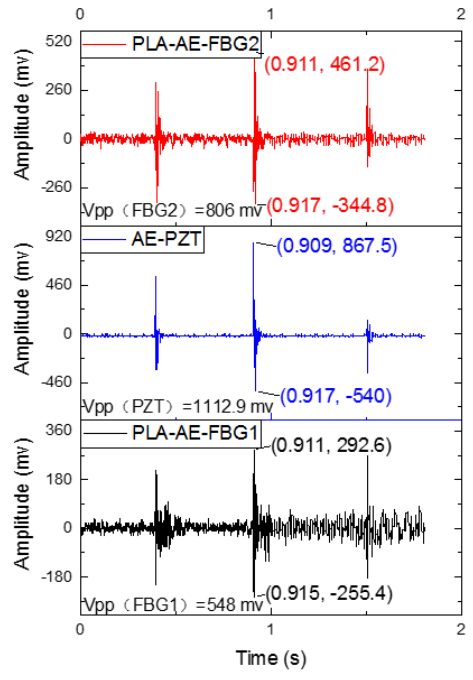
Figure 14. Amplitude-time curves.